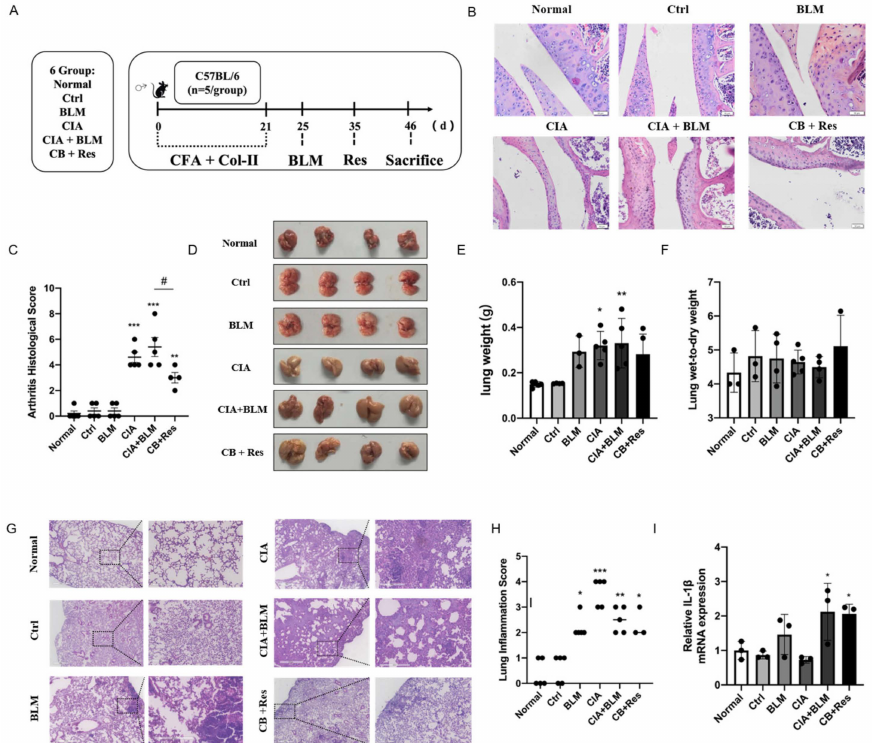
Figure 2. Resveratrol attenuated the inflammation of arthritis, and it did not aggravate lung inflam- mation in CIA+BLM mice. ( A ) CFA and chicken collagen type II were subcutaneously injected into the tail root of C57BL/6 mice on day 0 and 21, then treated with bleomycin on day 25, and resveratrol was taken orally on day 35, which lasted for 12 days. Then, the mice were sacrificed on day 46. ( B ) Representative H&E staining image of arthritis from each group of the study. Scale bars = 50 µ m, 40 × ( C ) The arthritis pathology score was estimated. ( D ) The lungs of each group are shown. ( E , F ) The lung wet weight and ratio of wet weight to dry weight were measured. ( G ) Representative image of pulmonary H&E staining shown at 40 × (left panels) and 200 × (right panels) magnification. Scale bar, 50 µ m. ( H ) Assessment of inflammation in every group. ( I ) The mRNA levels of IL-1 β were quantified. Values represent the mean ± SEM (n = 3–5). Compared with the normal group, * p < 0.05, ** p < 0.01, and *** p < 0.001; compared with the model group (CIA+BLM), # p <